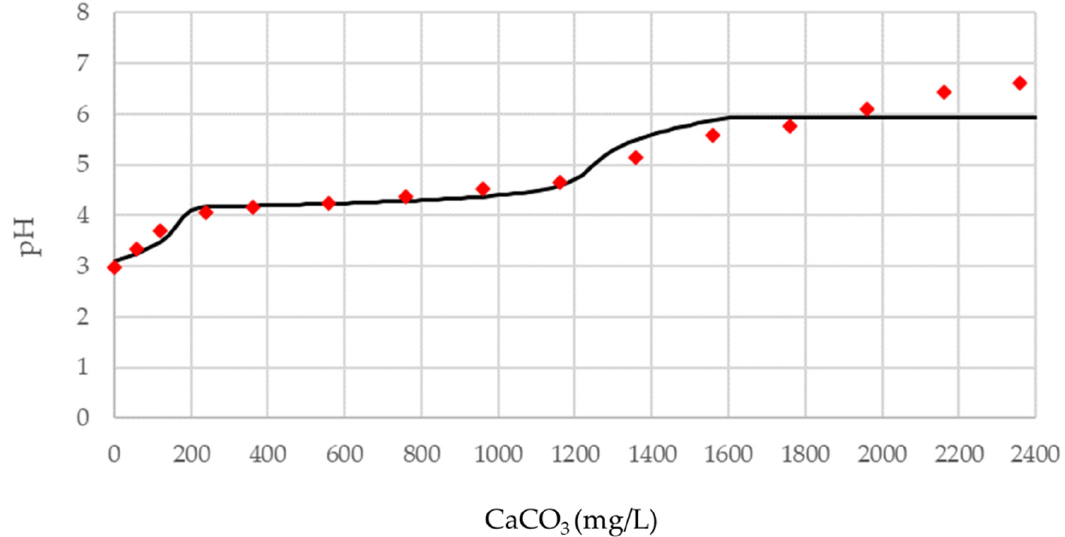
Figure 11. Leached buffered sample FA3, modeling geochemical curve (black line) compared with values of buffering test (red diamonds). Liquid samples FA3-S and FA3-L represent the buffered points where respective precipitates were collected. The conceptual scheme just described applies to the graph in Figure 12, referring to sample FA4. The theoretical curve is very different at the same range of buffer concentrations considered, compared with the FA3 solution sample. The acidity of the solution shows stable values over a significantly shorter buffer concentration range, specifically between 120 mg/L and 360 mg/L, corresponding to pH values at which precipitates were formed. The blue circles, which correspond to the amounts of buffering agent added during the test and the respective pH, have a good correspondence up to buffer concentrations of 360 mg/L. Thereafter, there is a shift between the calculated and observed data. Two flat trends can be observed: between 120 mg/L and 360 mg/L and a minor one between 960 mg/L and 1160 mg/L.